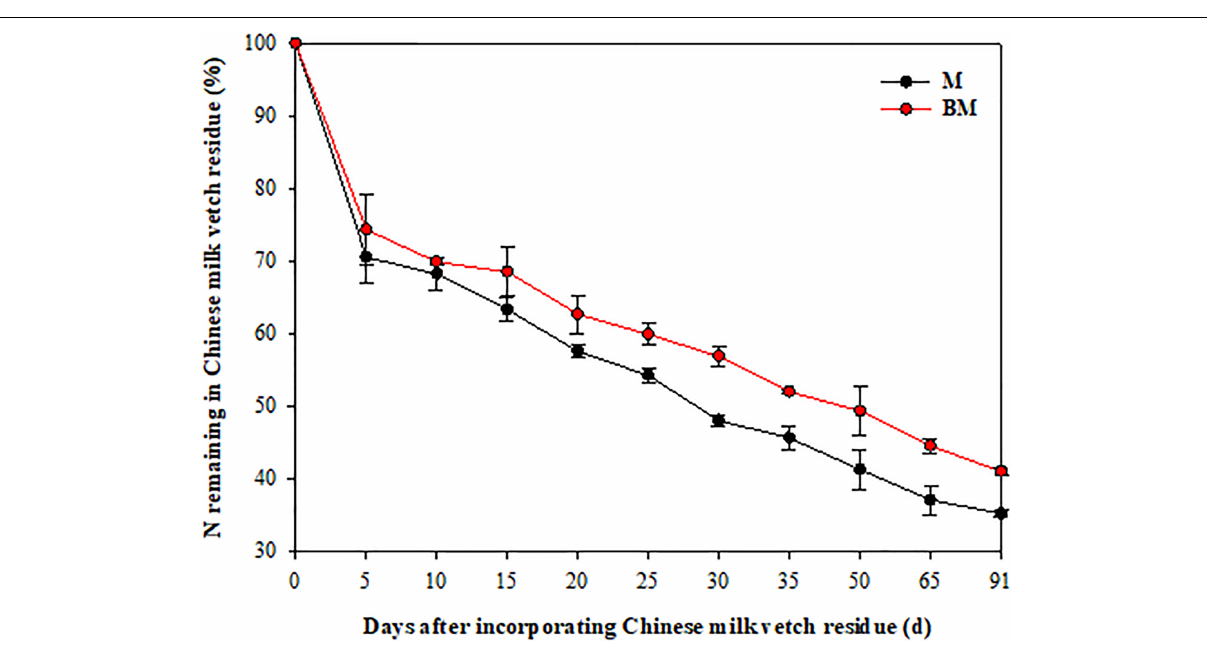
FIGURE 2 | Nitrogen release pattern of leguminous cover crop residue after incorporation to reddish paddy soil. Small bars are standard